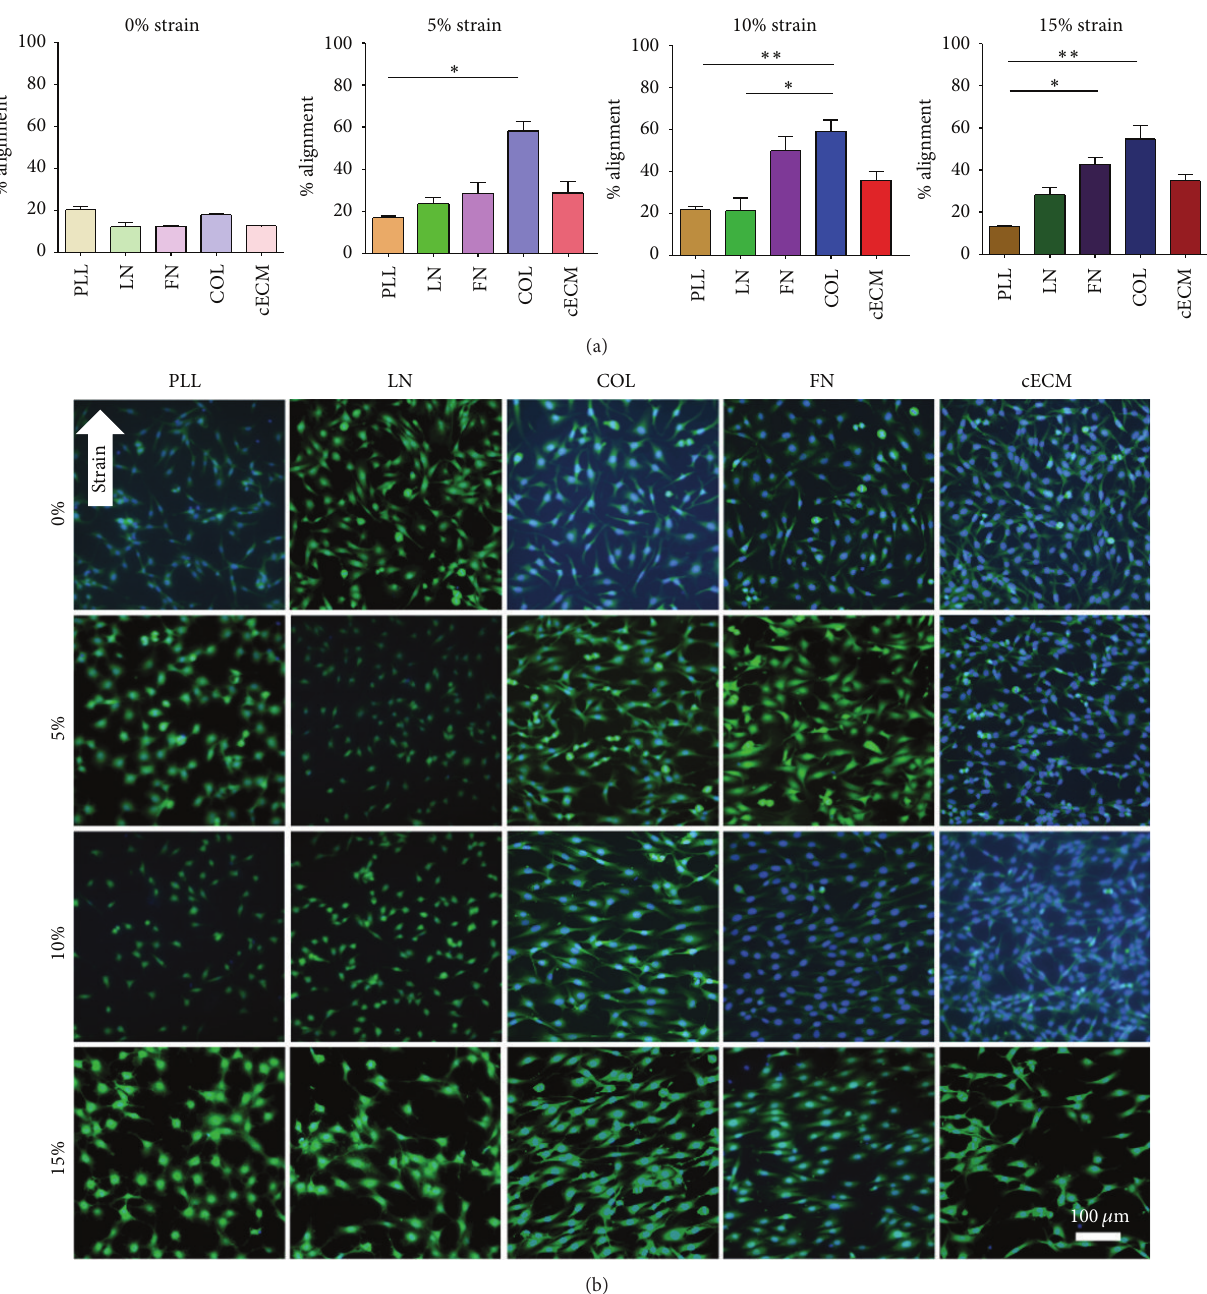
Figure 6: Strain induces CPC alignment. CPCs were seeded on each matrix for 6 hours and then cyclic strain was applied for 24 hours. (a) Quantification of strain-induced matrix-dependent alignment. Kruskal-Wallis one-way ANOVA with Dunn’s multiple comparison tests; bars represent mean + SEM; ∗ 𝑝 < 0.05 and ∗∗ 𝑝 < 0.01 ; 𝑛 = 4 –7; PLL (brown): poly-L-lysine, LN (green): laminin, FN (purple): fibronectin, COL (blue): collagen I, and cECM (red): naturally derived cardiac extracellular matrix. (b) Representative cell strain images. Blue: DAPI and green: FITC-maleimide; arrow indicates principle direction of strain; 0–15: strain magnitude (%).